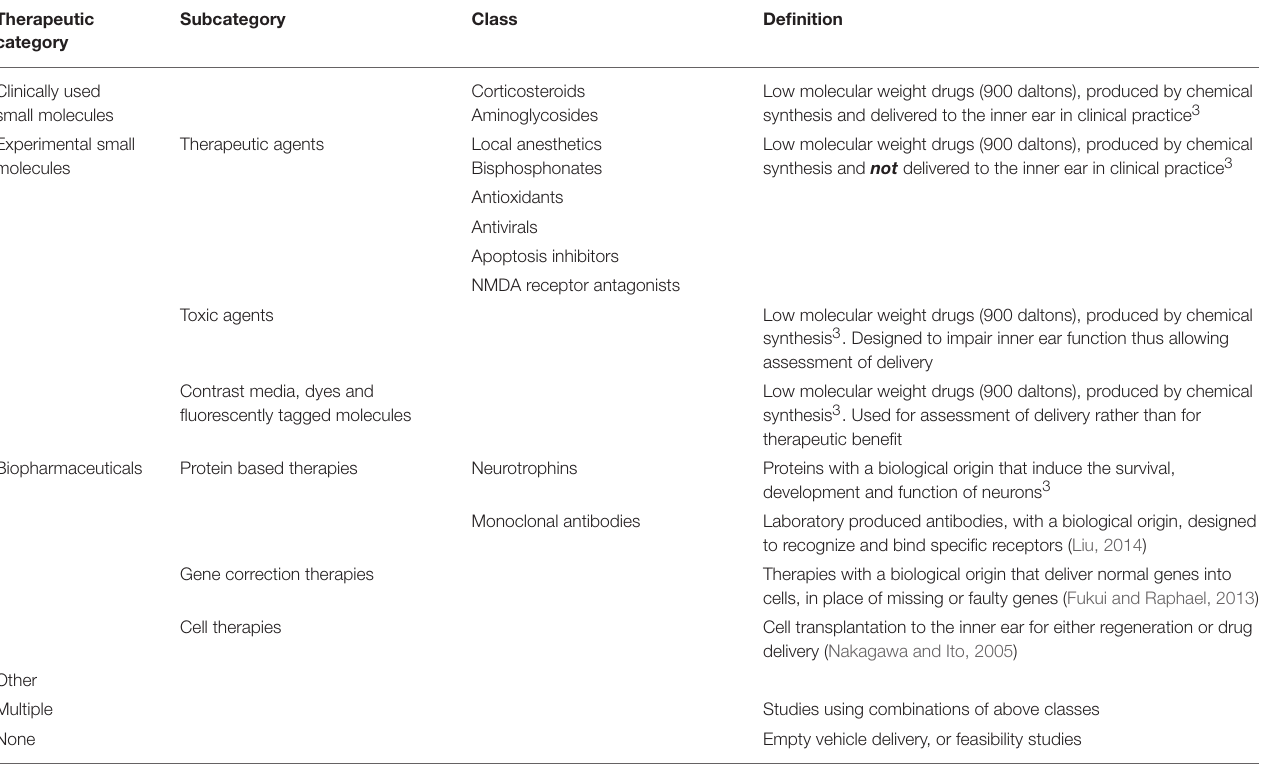
TABLE 4 | Categorization of therapeutics locally delivered to the inner ear with definitions. Therapeutic